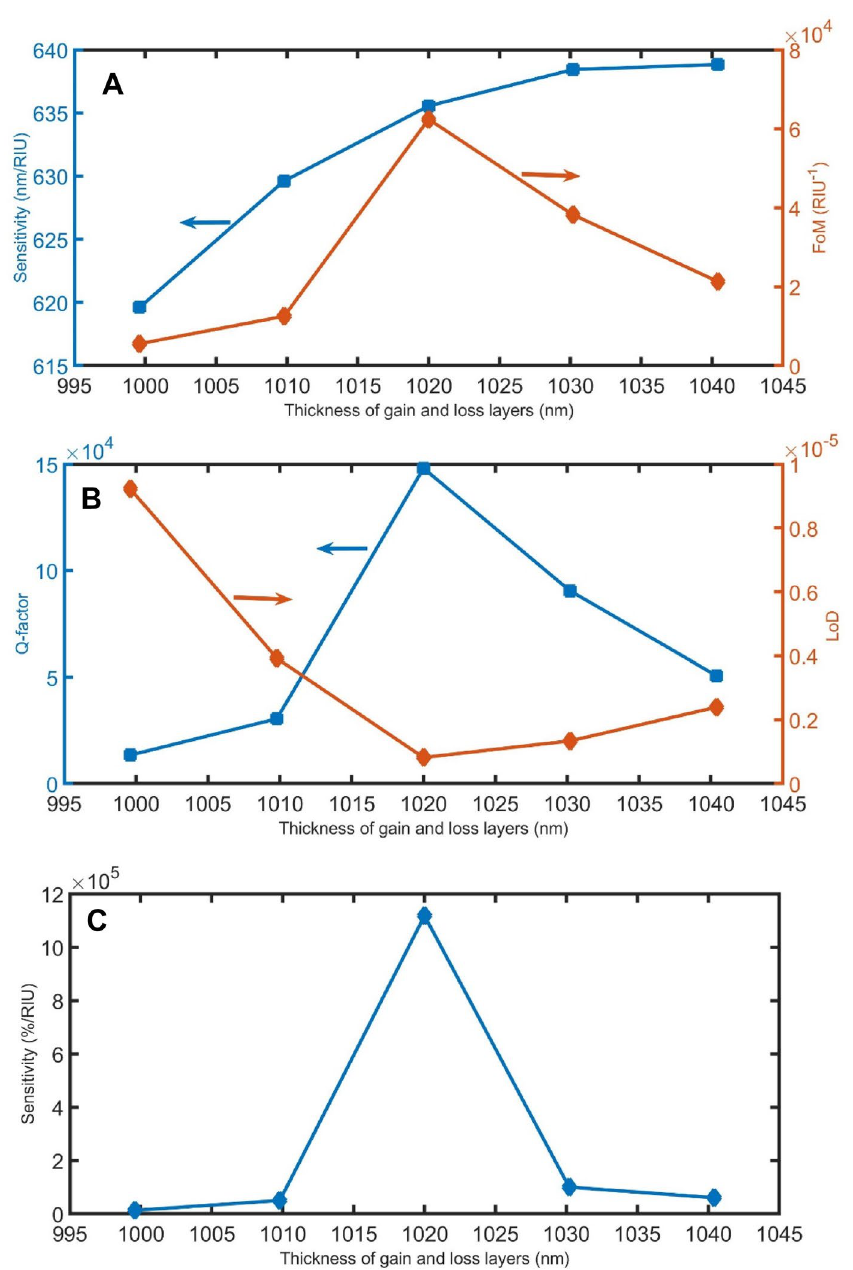
Figure 9. The ( A ) sensitivity in nm/RIU and FoM, ( B ) Q-factor and LoD, and ( C ) sensitivity in %/RIU, with varying the thickness of the gain and loss